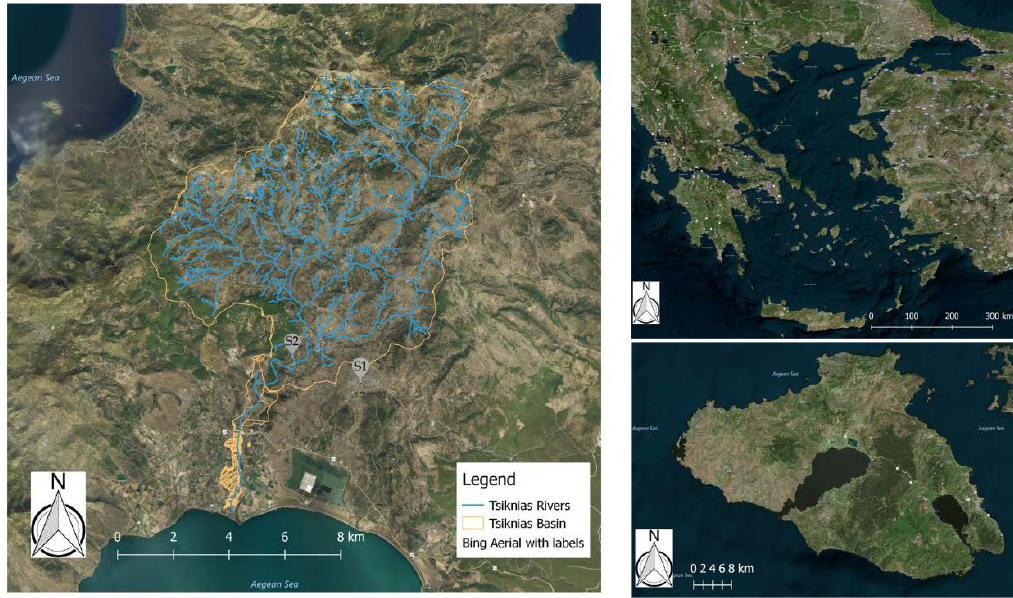
Figure 1. The Tsiknias River catchment ( Left ; upper Right : Greece; lower right: Island of Lesvos).